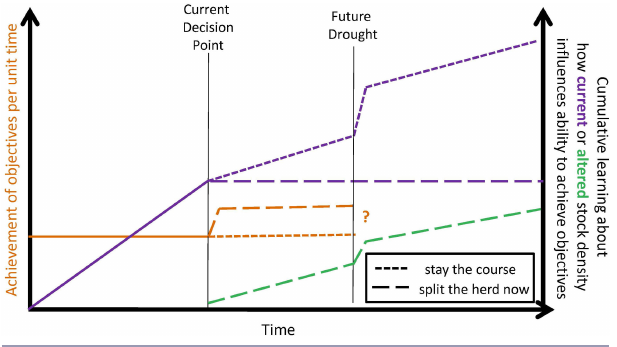
Fig. 8 . Learning opportunity cost. The decision to alter a management strategy within collaborative adaptive rangeland management (CARM) may improve the system’s ability to achieve objectives, e.g., improve weight gain in the short term (orange lines) but will also remove opportunities to learn about longer term outcomes of the current management strategy, e.g., performance of current strategy during drought (purple